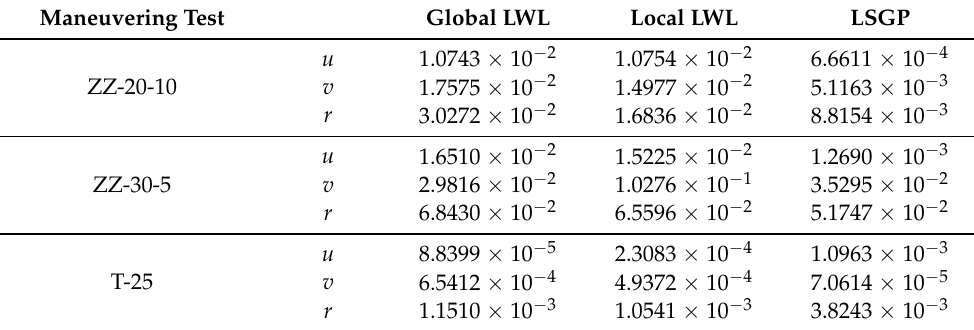
Table 2. Comparison of the prediction accuracy for different methods. Maneuvering Test